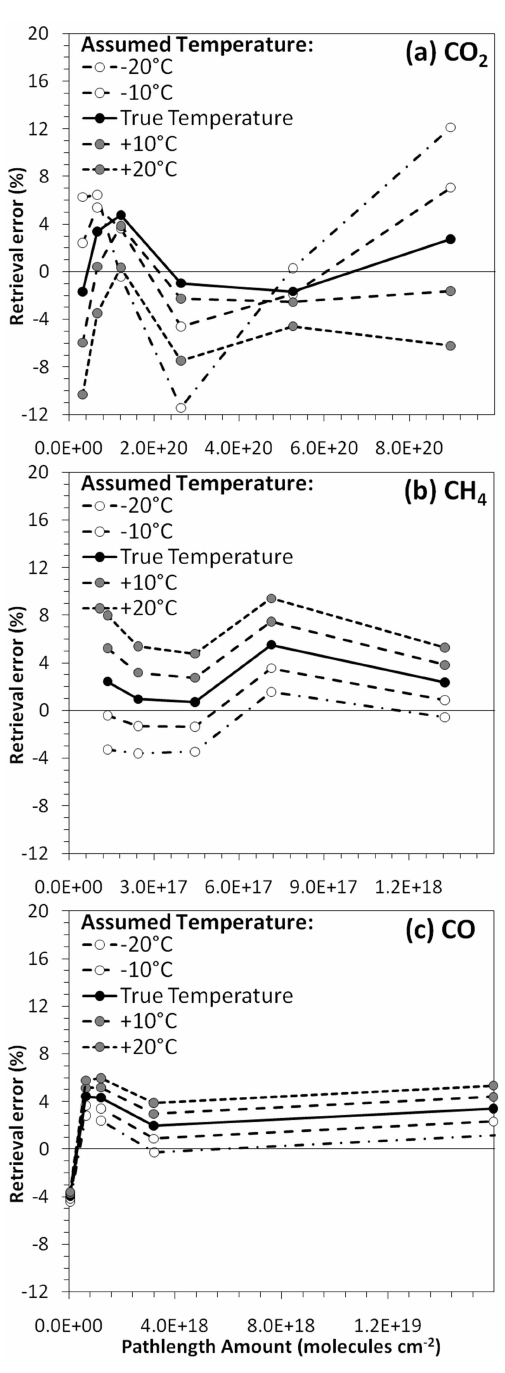
Fig. 12. Sensitivity of trace gas concentration retrieval error to the assumed gas temperature for (a) CO 2 , (b) CH 4 , and (c) CO. Re- trievals were made using the MALT model with a NLLS fitting pro- cedure. The same y-axis range is used in each case to aid compari- son of error magnitude between gases.